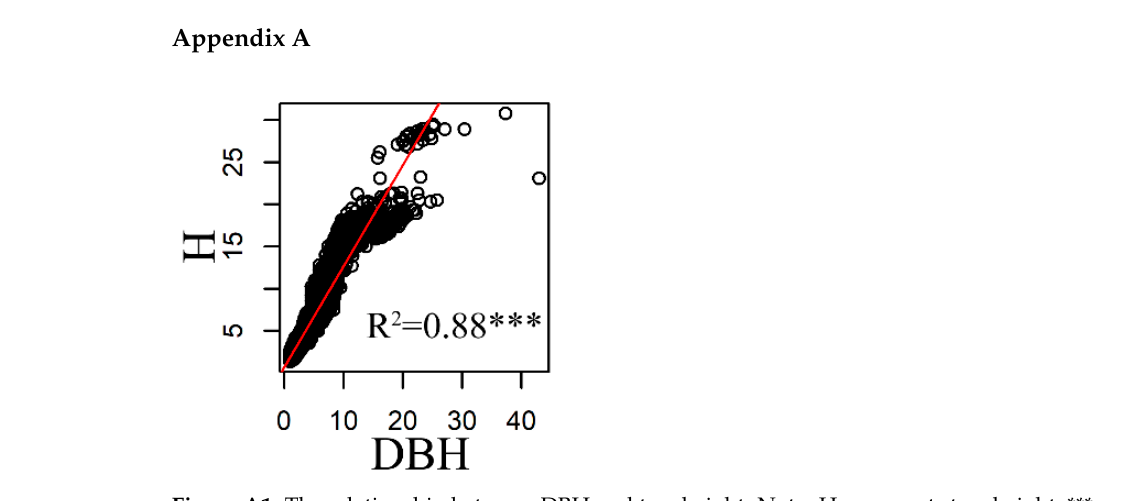
Figure A1. The relationship between DBH and tree height. Note: H represents tree height; *** repre- sents the significance.